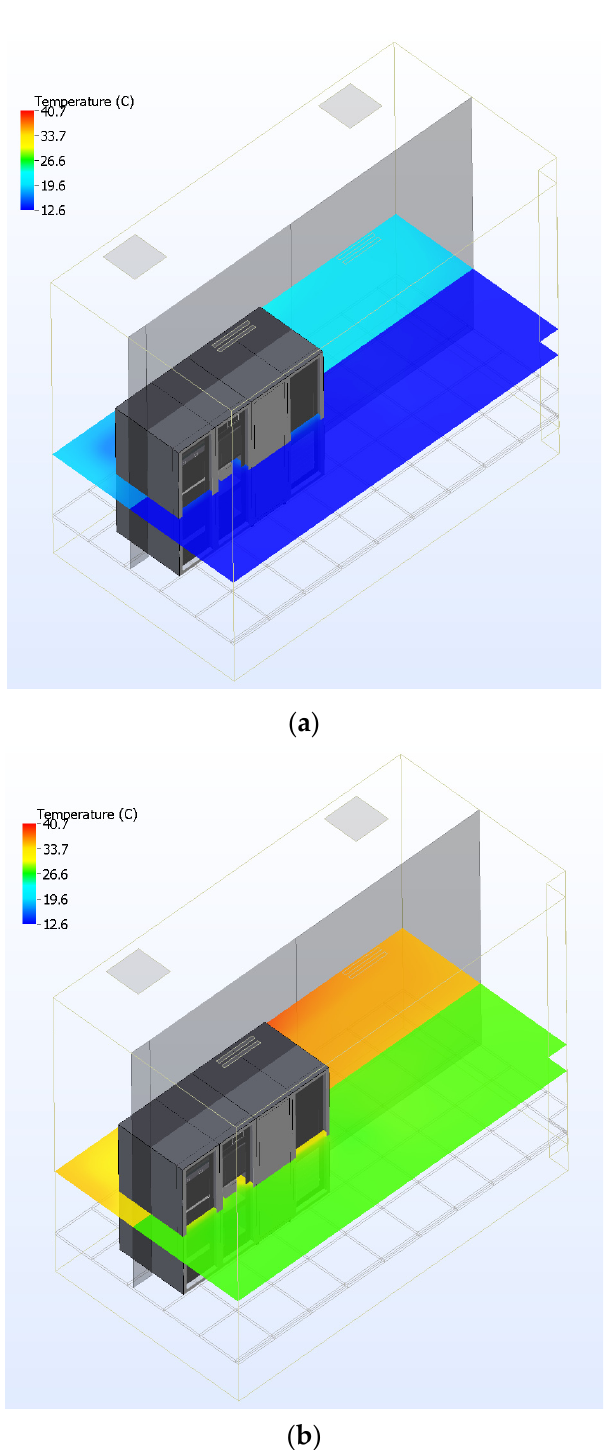
Figure 4. Temperature distribution: ( a ) ECM #2.1; ( b ) ECM #2.2.